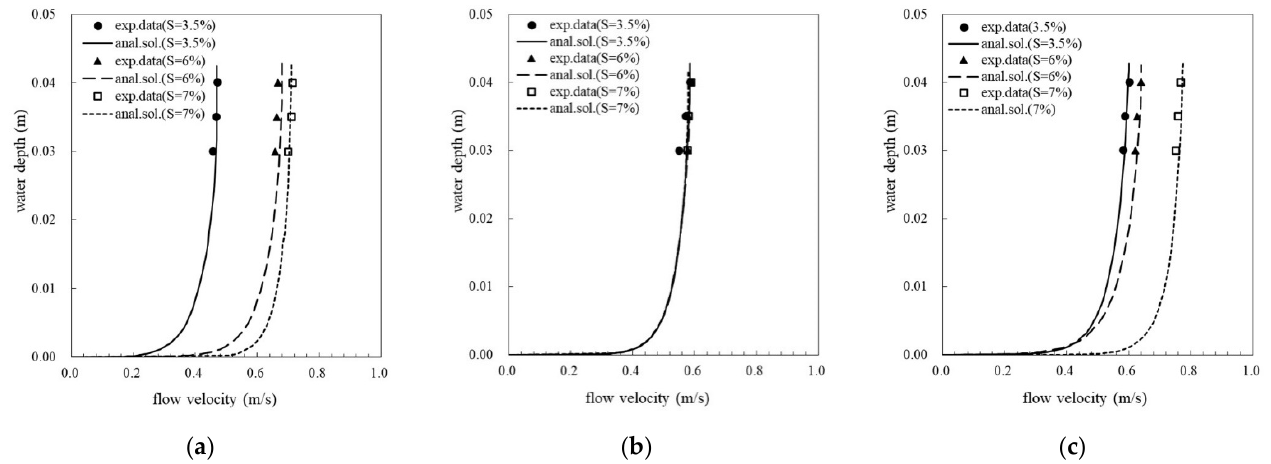
Figure 6. Velocity profiles in the grassed flume with ( a ) Centipede grass, ( b ) Bermuda grass, and ( c ) Carpet grass.